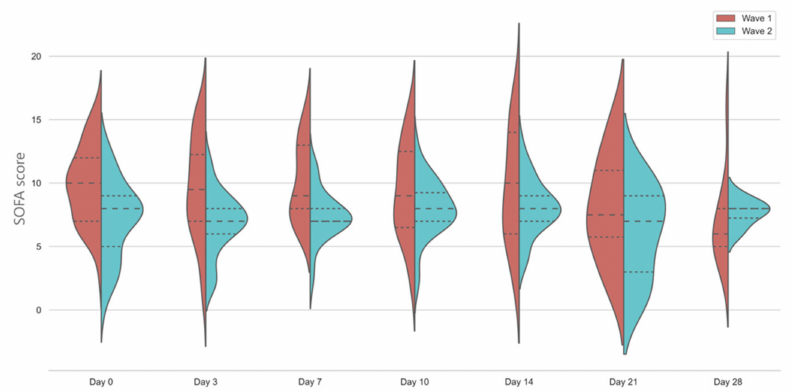
Figure 4. Temporal changes in SOFA scores in the first and second wave. Violin plots represent the distribution of data. Dashed lines show medians and interquartile ranges. The general linear model indicates significant differences between days in wave 1 and between groups, p <